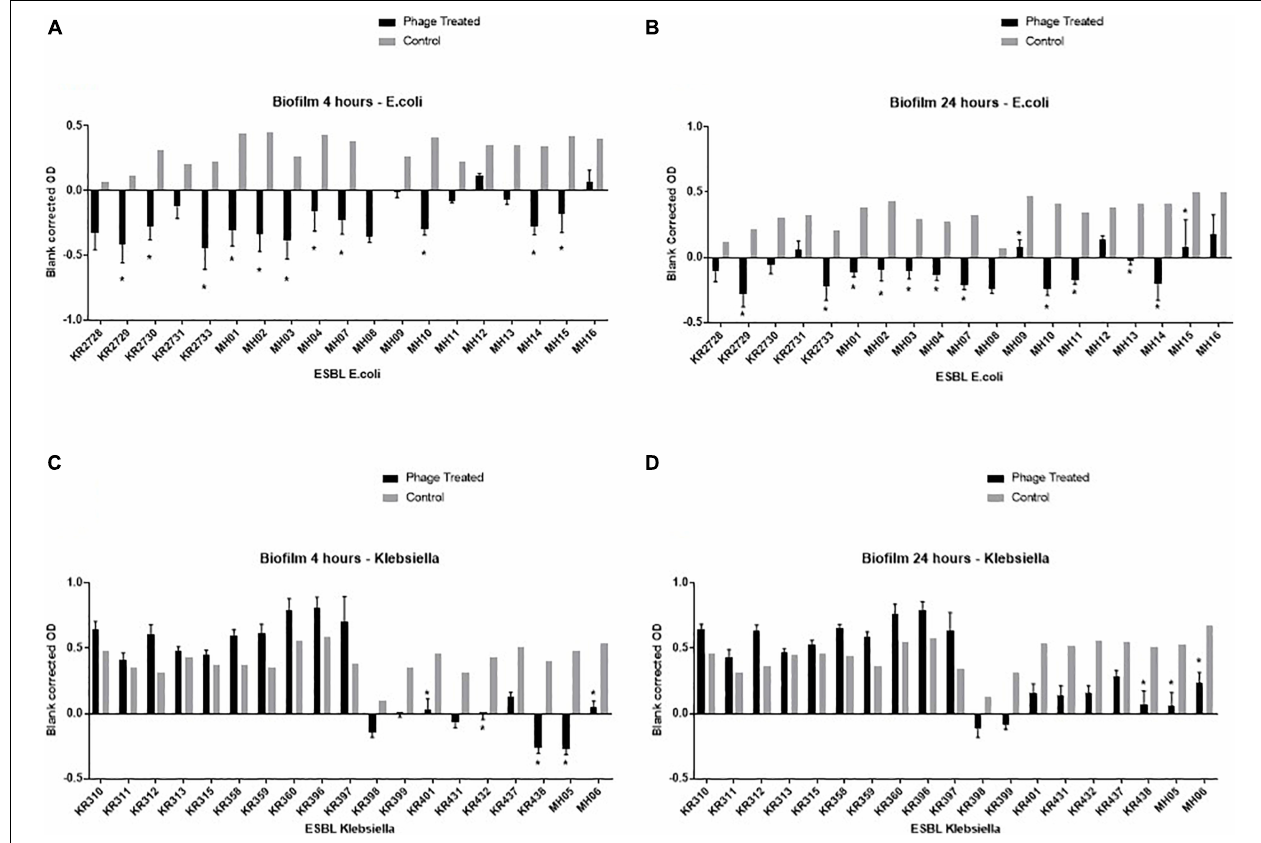
FIGURE 3 | Graphical representation of the biofilm assay data—resazurin cell viability-based model on a 96 well plate. Clinical isolates were grown for 24 h on a flat bottom 96 well plate, then incubated for an additional 24 h with either LB (control) or the final phage cocktail (phage treated). Resazurin was then added, OD readings were taken at 4 and 24 h post adding resazurin. Each ESBL-producing clinical isolate has two bars: the black bar represents the phage treated blank corrected OD and the grey bar represents the control blank corrected OD. OD taken at A 595 , experiments repeated in triplicate for all clinical isolates, columns represents mean with standard error of the mean. * = significance difference between those treated with final phage cocktail and the control, p < 0.05. The top left graph (A) depicts the all ESBL producing E.coli clinical isolates 4 h post incubation with resazurin, top right (B) depicts ESBL producing E.coli clinical isolates 24 h post incubation with resazurin, the bottom left (C) depicts all ESBL-producing Klebsiella clinical isolates 4 h post incubation with resazurin and bottom right (D) depicts all ESBL-producing Klebsiella clinical isolates 24 h post incubation with